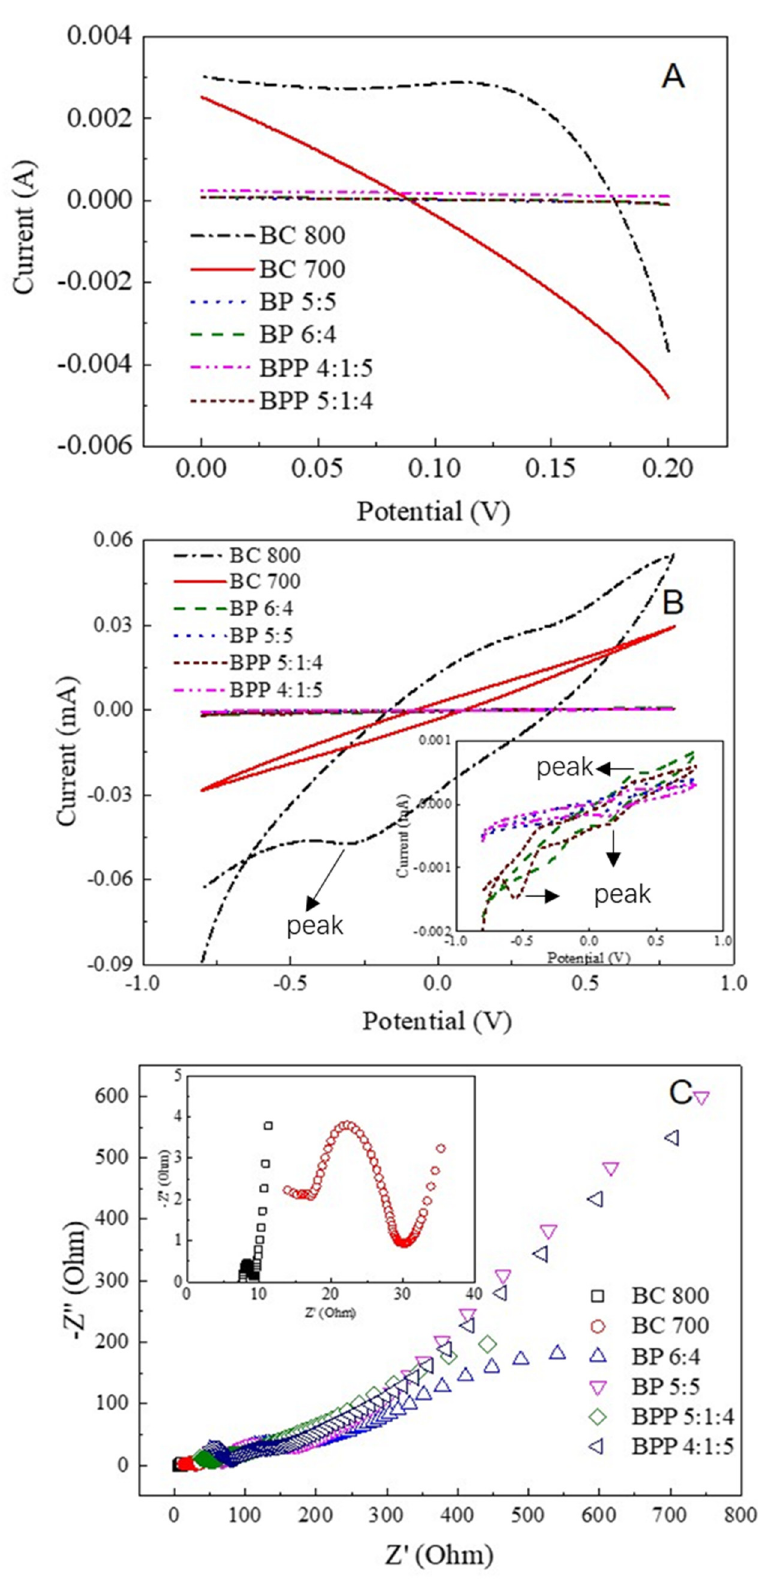
Figure 2. The Linear sweep voltammetry, Cyclic voltammetry, and Electrochemical impedance spectroscopy test results of six biochar − based electrode materials ( A ) Linear sweep voltammetry curves, ( B ) Cyclic voltammetry curves, ( C ) Electrochemical impedance spectroscopy curves.